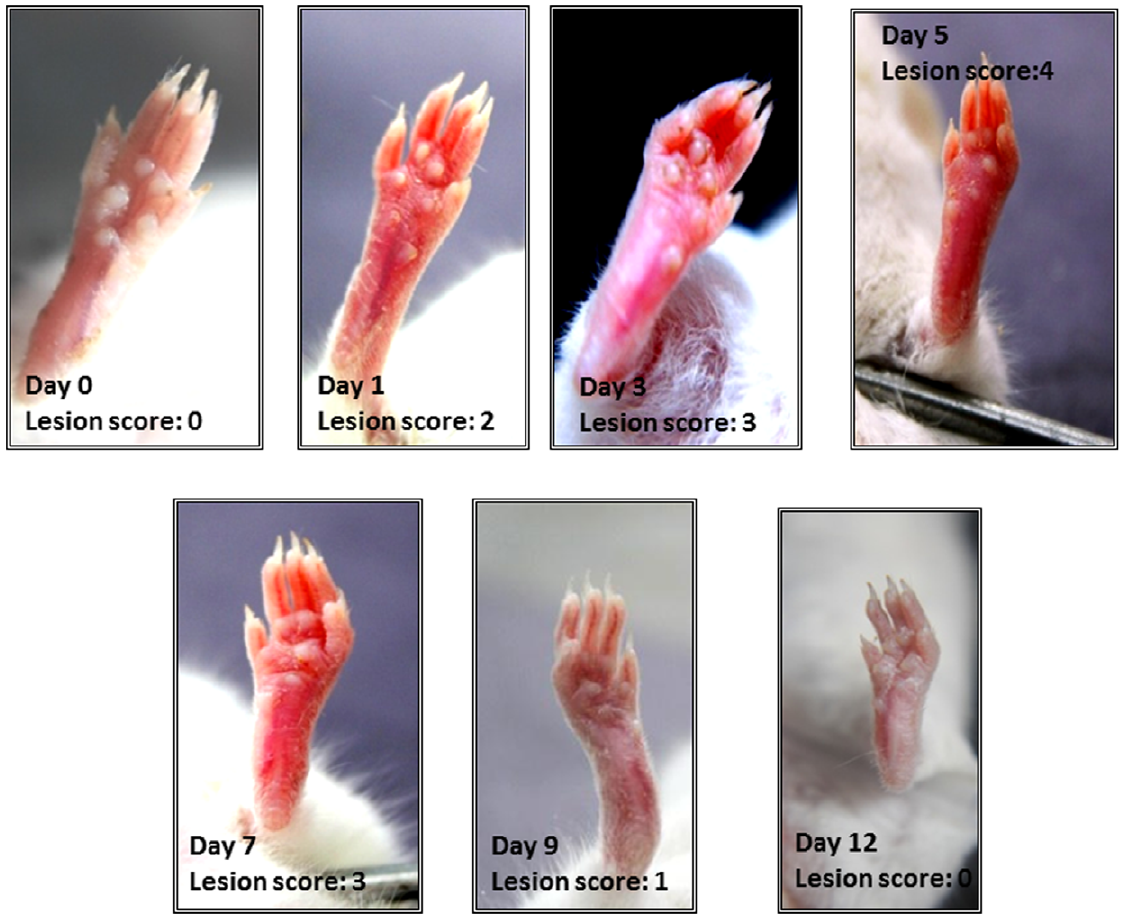
doi:10.1371/journal.pone.0056022.g003